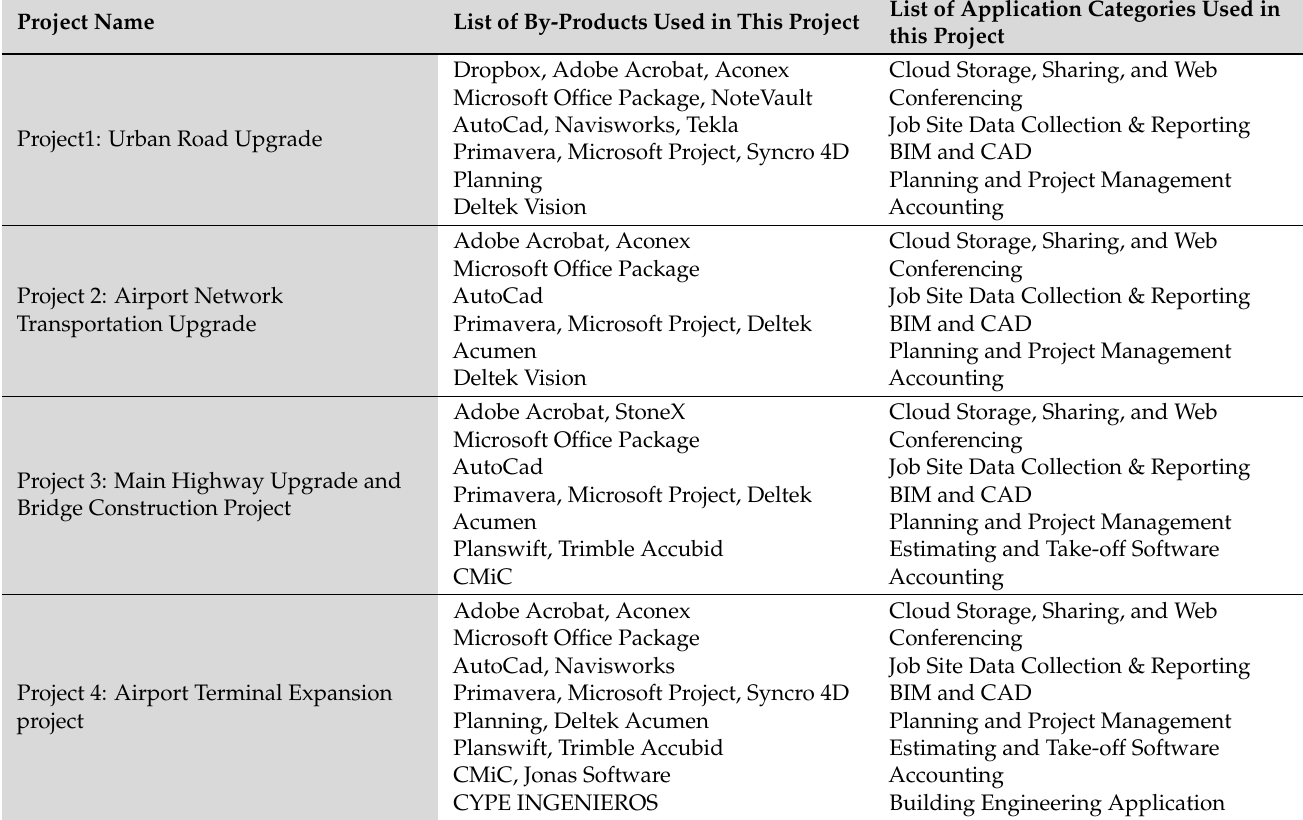
Table 3. List of ICT applications and categories implemented in each project case